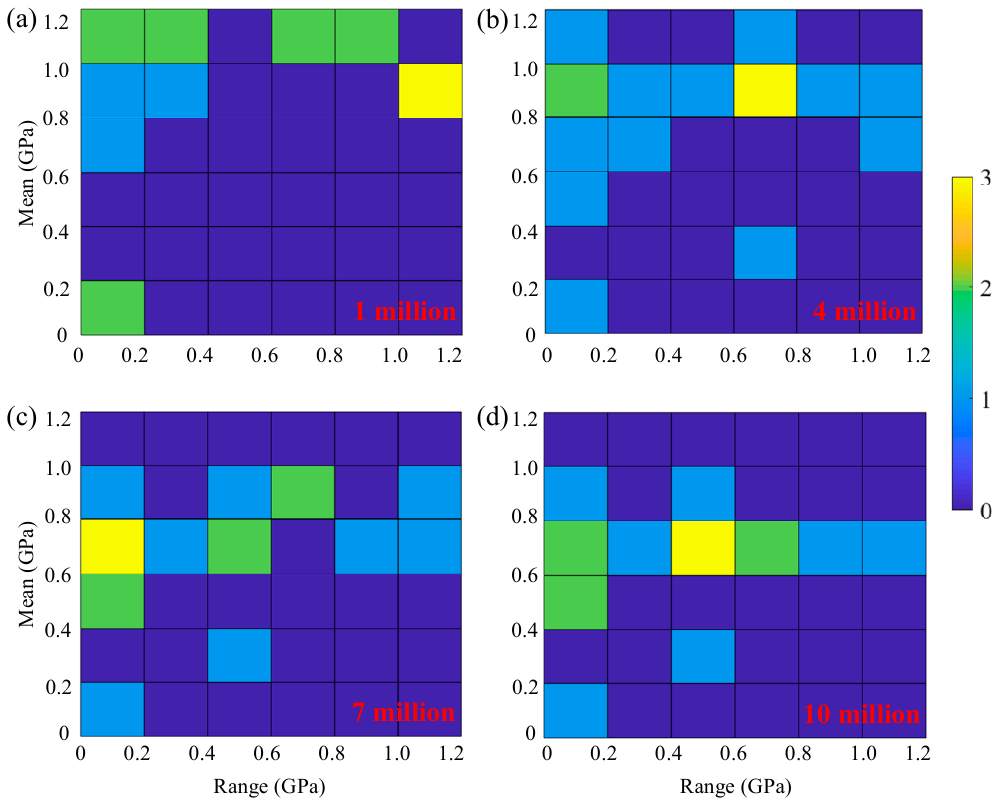
Figure 12. Stress spectrum during 10 million cycles.